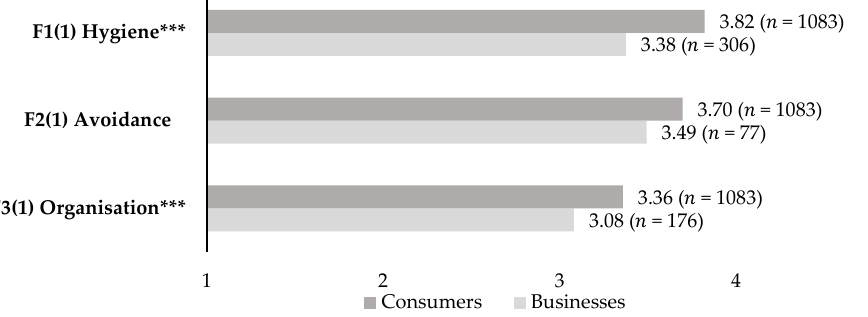
Figure 1. Expected safety measures: consumers’ attitudes vs. businesses’ expectations of their cus- tomers’ attitudes. Note: not all statements were evaluated by all business owners due to irrelevance, explaining the differences in n between factors; *** p < 0.001; FX(Y) with X = number of factor, Y = number of study.